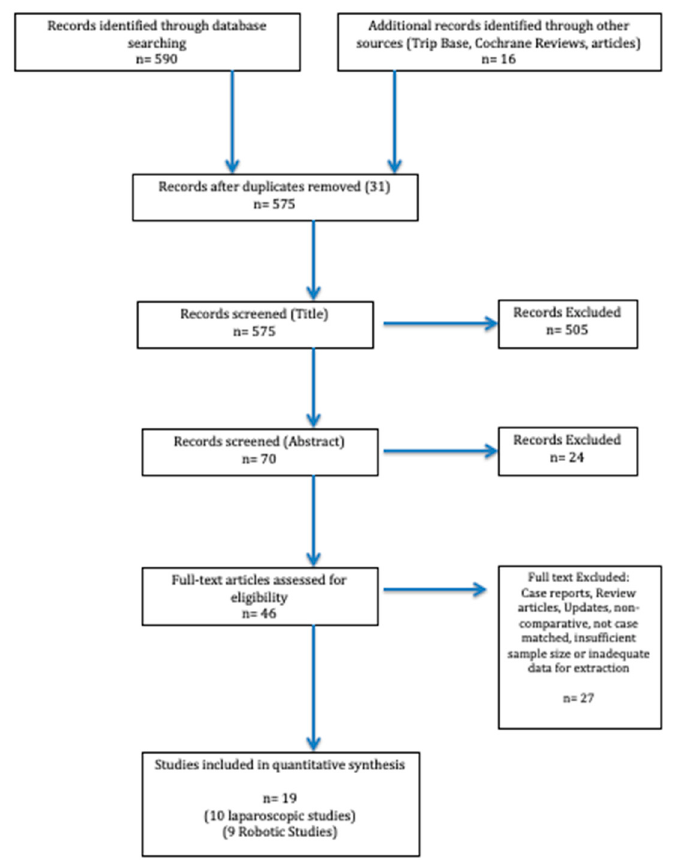
Figure 2. PRISMA flow diagram illustrating the article selection process for the systematic review. PRISMA, Preferred Reporting Items for Systematic Reviews and Meta-Analysis.